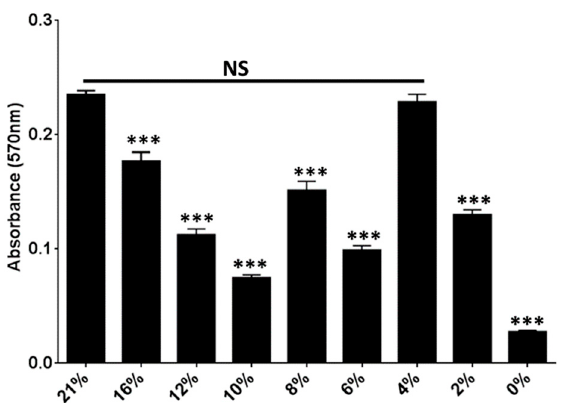
Figure 5. UTI89 biofilm formation is affected by oxygen concentration changes. Graph depicting the relative abundance of biofilm formed by UTI89 during growth in decreasing oxygen concentrations. This graph depicts the average of a minimum of three biological replicates per condition tested. Statistical analysis was performed using two-tailed Mann-Whitney method, comparing values for each condition to the values of biofilm formed under atmospheric (21%) oxygen. *** p < 0.0001, NS not significant.